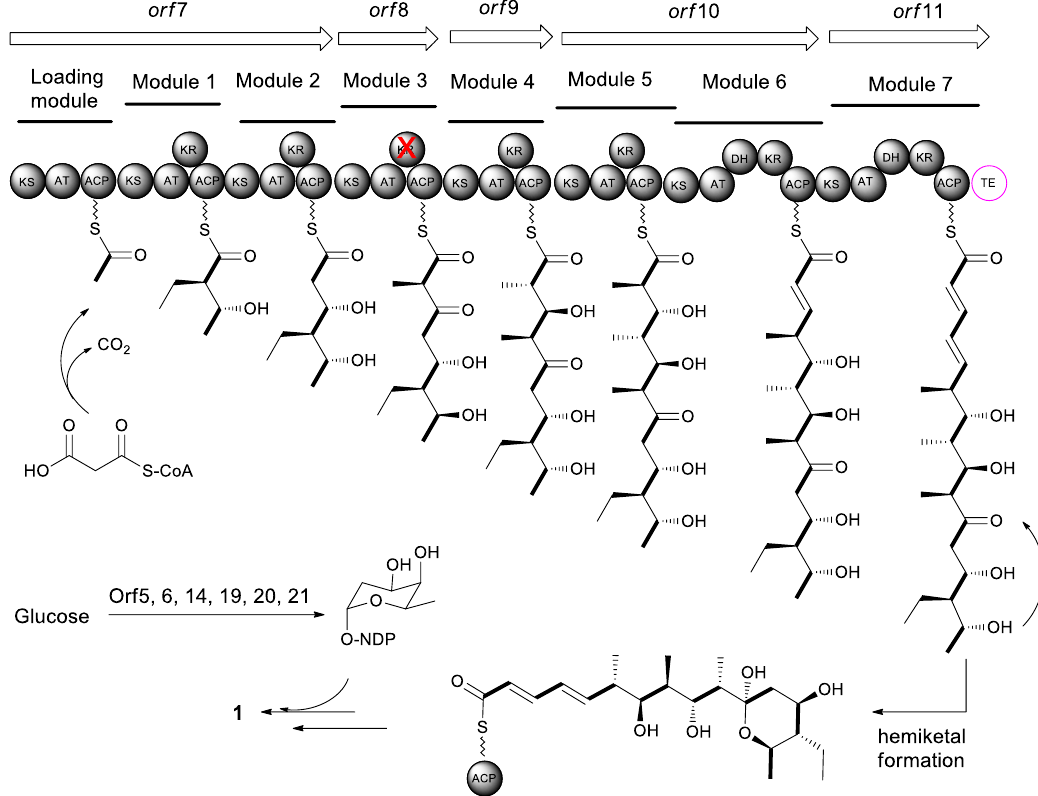
Figure 3. Proposed elaiophylin PKS assembly line.